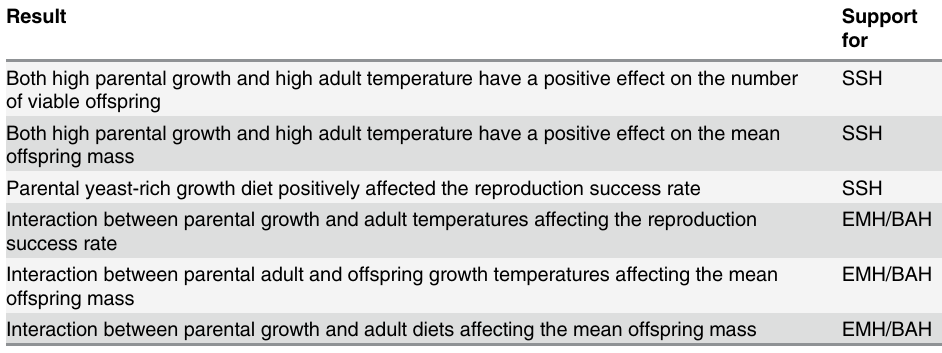
for SSH SSH EMH/BAH EMH/BAH